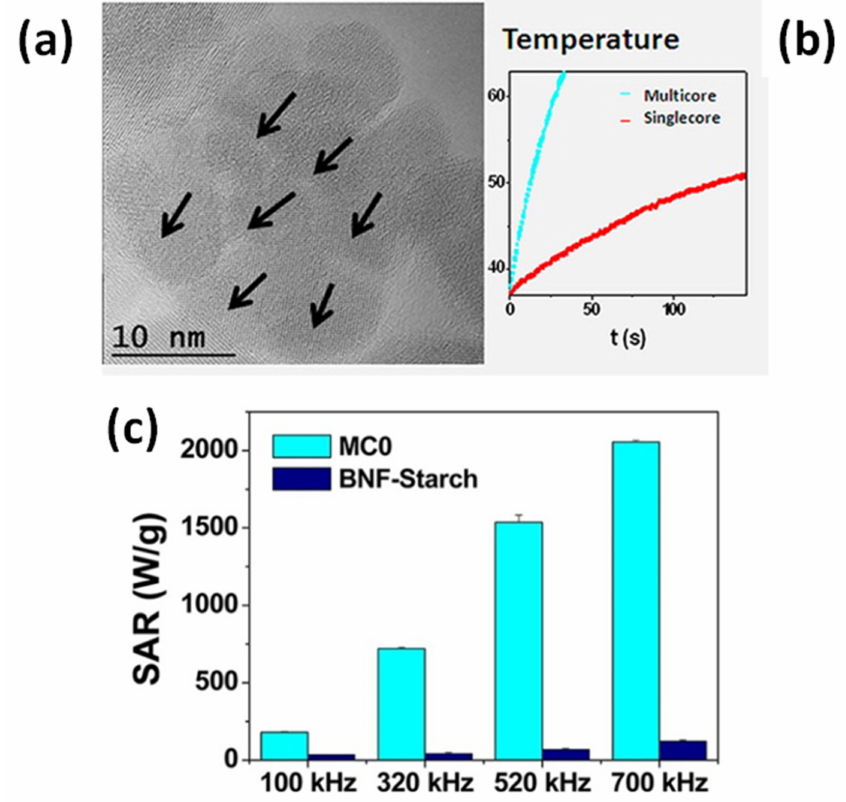
Figure 5. ( a ) High resolution TEM image of a maghemite MC_NP consisting of merged grains with the same crystalline orientation. ( b ) Heating curves measured on the MC_NPs and on single-core NPs (AMF of 29 kA/m and 520 kHz). ( c ) SAR value comparison between the MC_NPs (sample called MC0) and commercial magnetite NPs (BNF_starch) at different frequencies for a magnetic field amplitude of 25 kA/m. Adapted with permission from Ref. [156], Copyright 2012 American Chemical